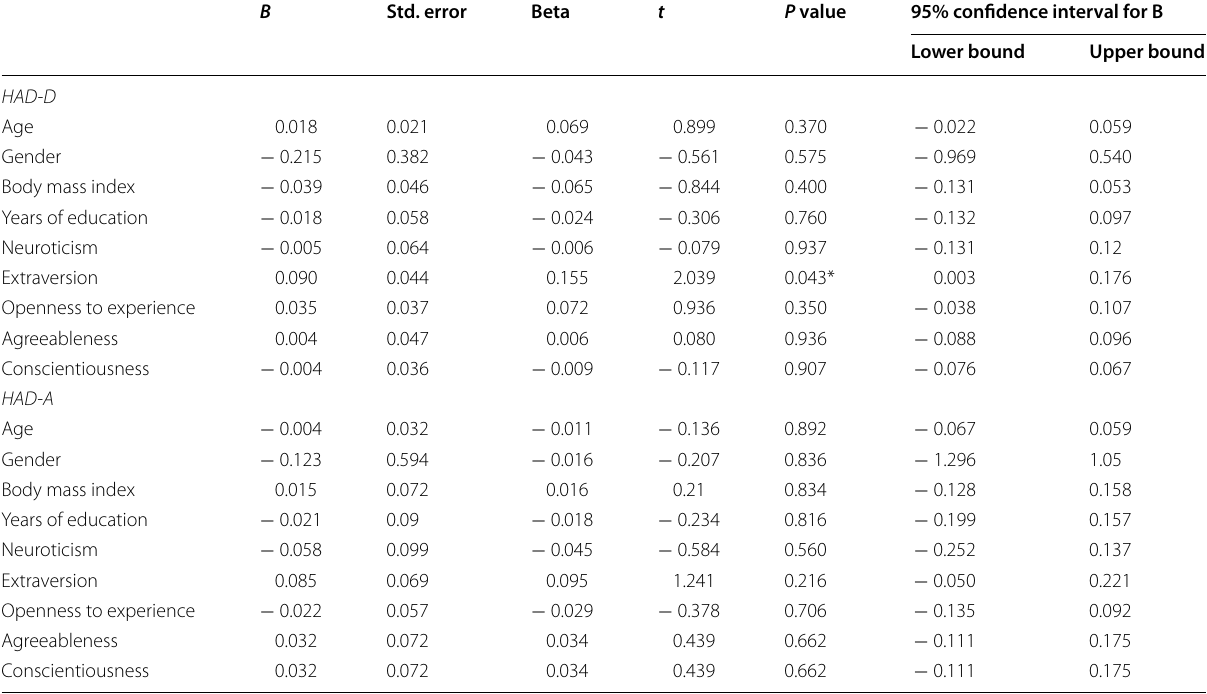
Table 5 Univariate linear regression for difference between pre-post treatment scores of HAD-D and HAD-A with other parameters B Std.